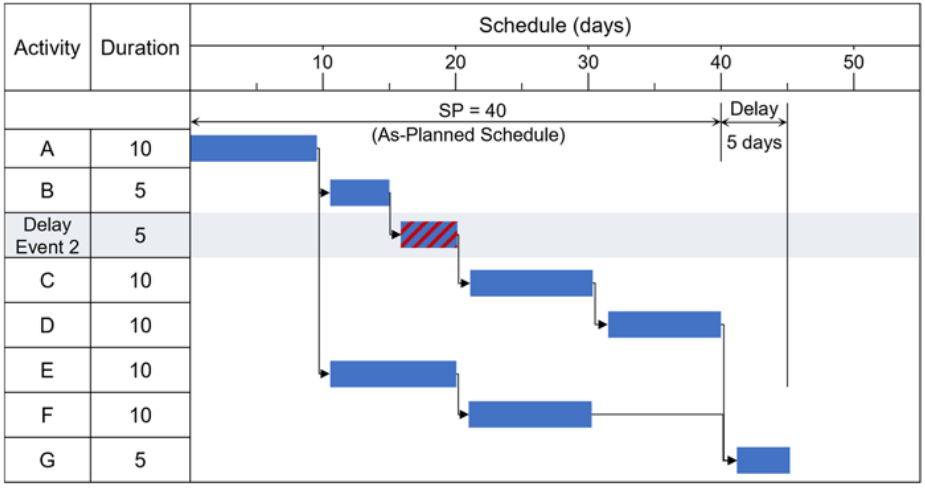
Figure 3. Impacted as-planned schedule by delay event 1 (owner-caused delay). Next, as shown in Figure 4, “delay event 2” alone is added. Its total project duration becomes 45 days. Its estimated completion date is delayed 5 days. It is analyzed that “delay event 2” has 5 days of impact. The contractor is liable for the delay, which is classified as “non ‐ excusable and non ‐ compensable (NN)”.